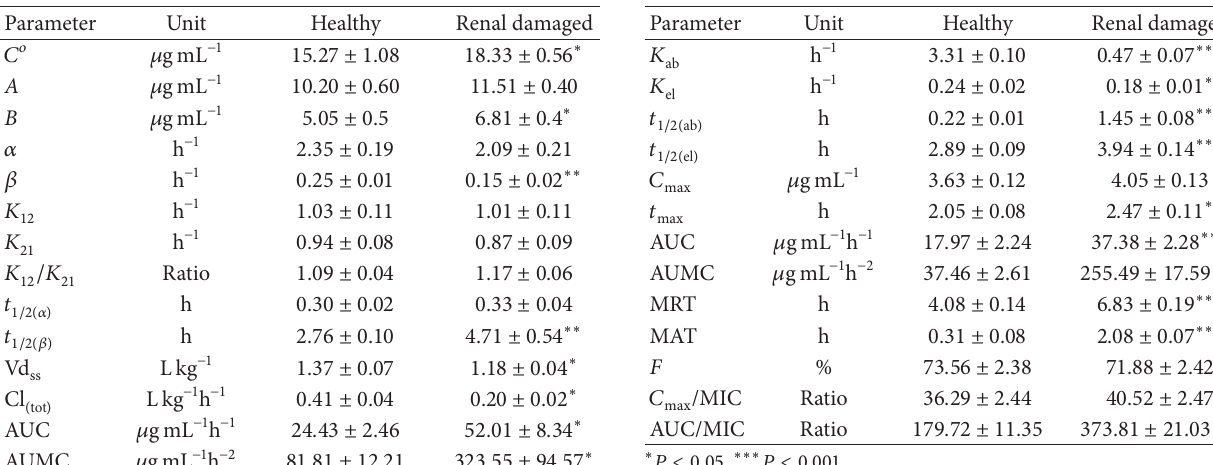
Table 1: Pharmacokinetic parameters of levofloxacin in healthy and renal damaged ducks after a single IV administration of 10mg kg − 1 bwt ( 𝑛 = 6 ).